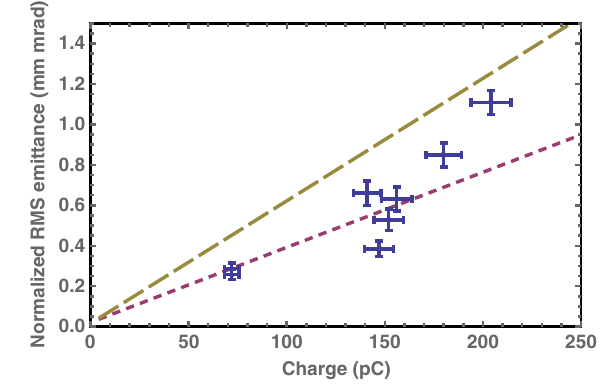
FIG. 10. Scaling of emittance with charge. Comparison of beam measurements taken by varying laser pinhole aperture to vary charge (blue bars) with simulation results using PARMELA and differing thermal emittance based on laser spot size. Lines plotted for thermal emittances of 0.55 (red fine dashed line) and 0 . 9 mm mrad = mm spot size (yellow coarse dashed